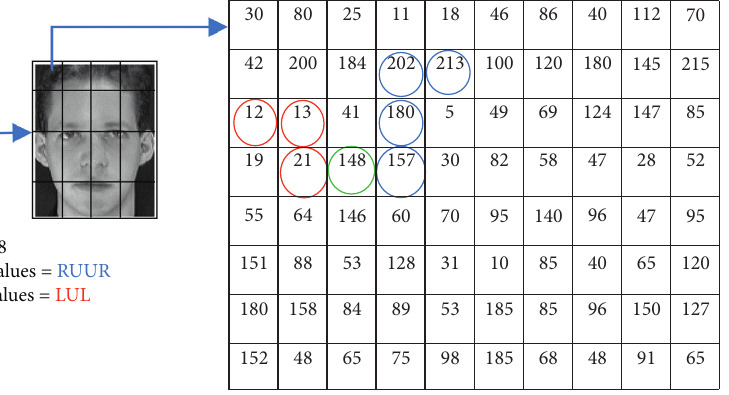
Figure 1: Obtaining strings from a starting pixel